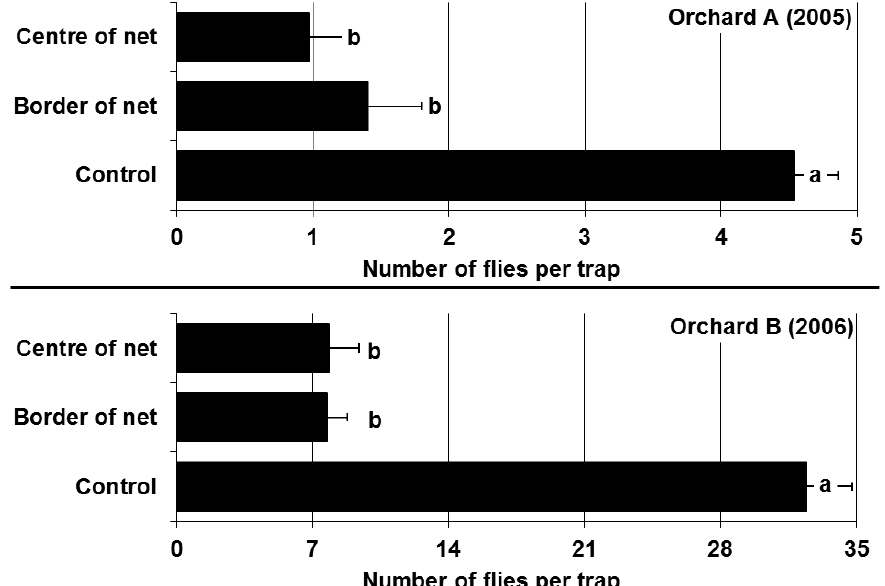
Figure 4. Effects of soil covering with netting on percentage infestation rate of cherries with R. cerasi larvae (±se) in the orchard B (2006). Statistical analysis: two-way ANOVA